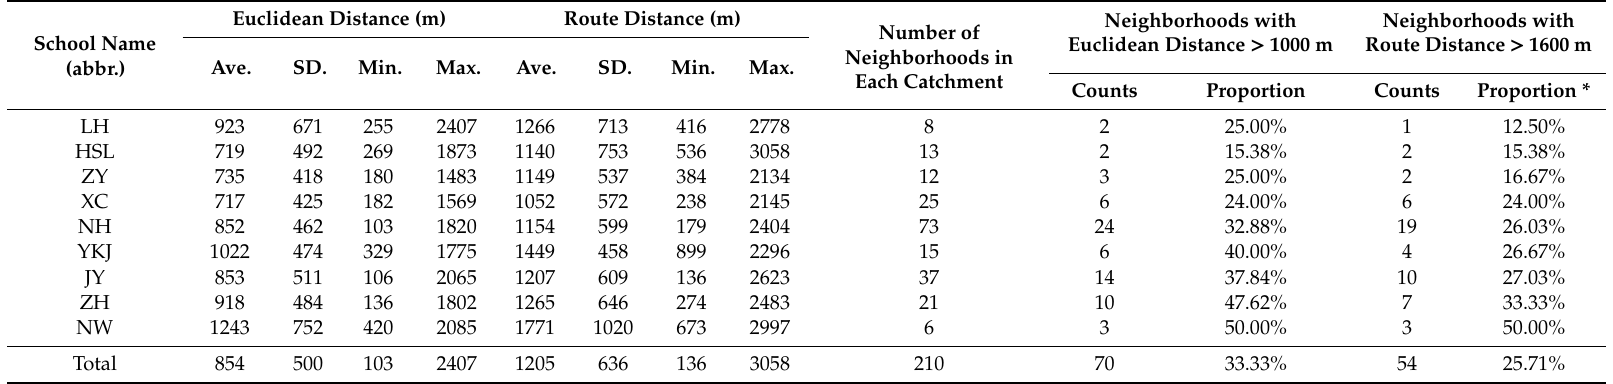
Table 2. Results of school catchments reassignment at the neighborhood